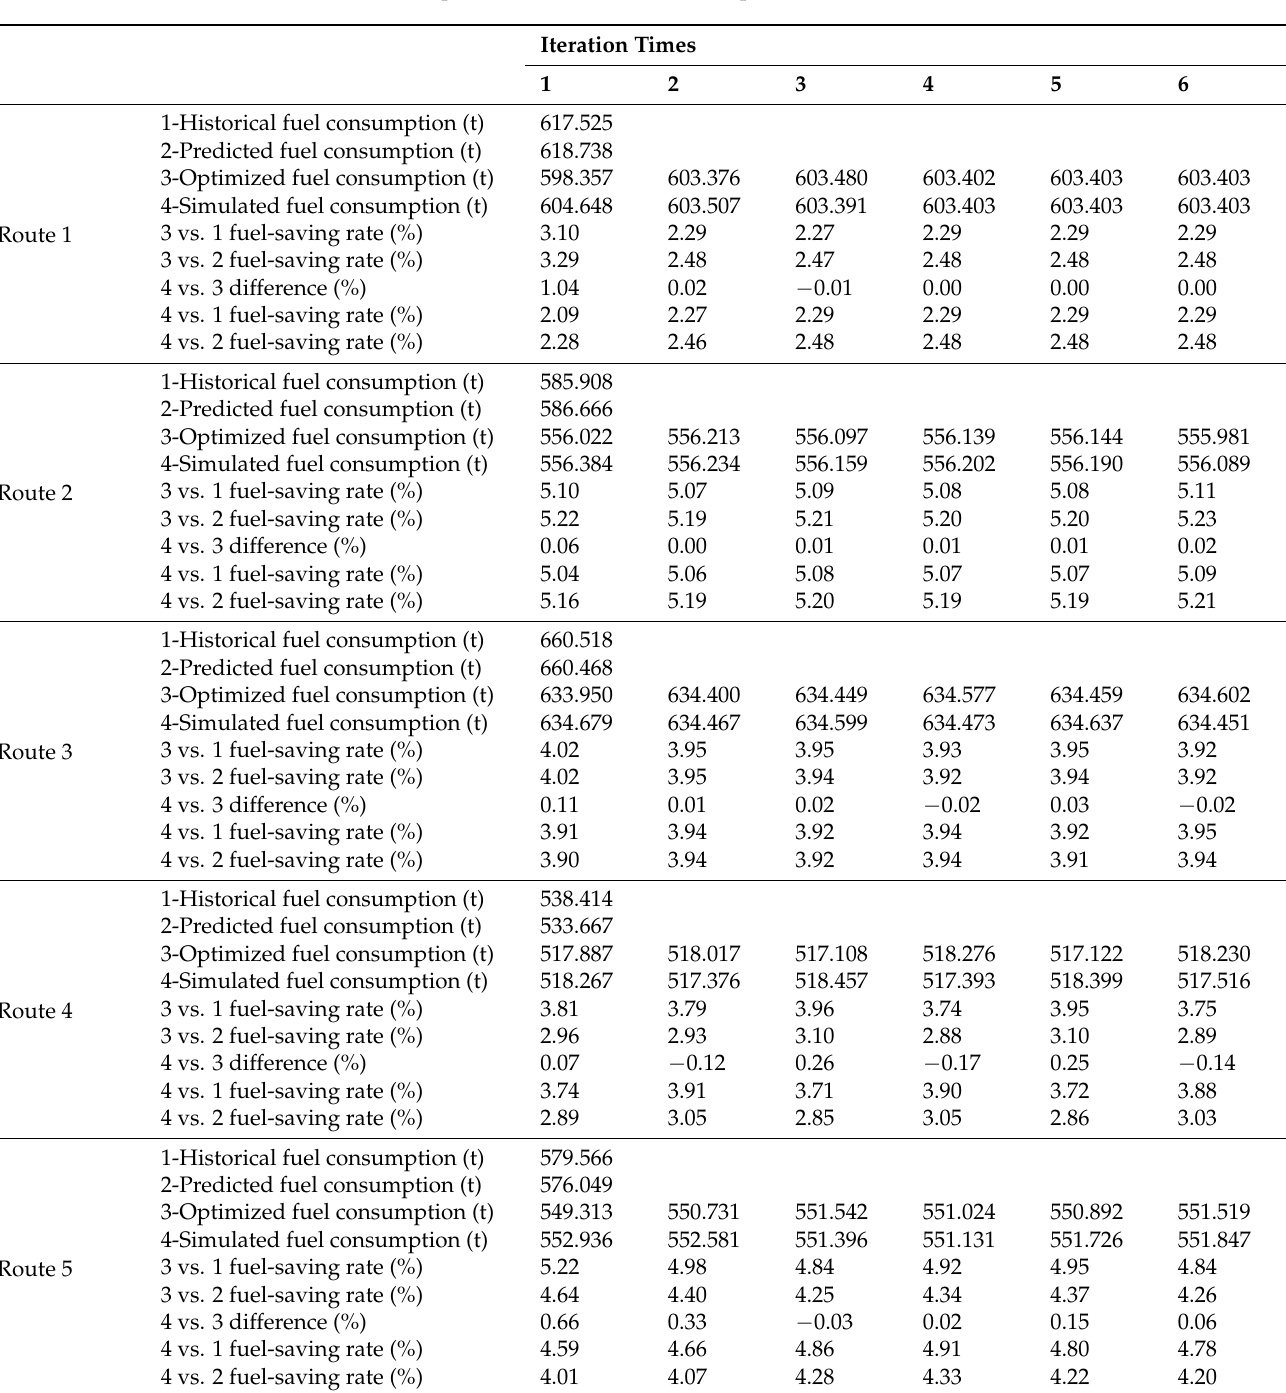
Table 5. Comparison results of fuel consumption under historical trim and draft